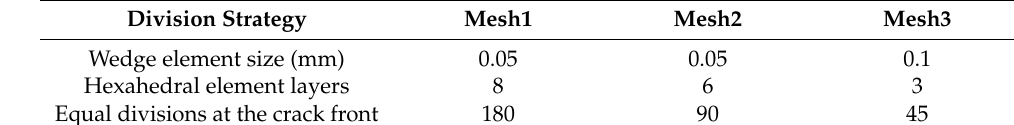
Figure 4. Effect of the mesh density on the normalized SIF at different angles, a/t = 0.2, a/c = 0.2. ( a ) Normalized K II , ( b ) normalized K III . Table 1. Crack front meshing.